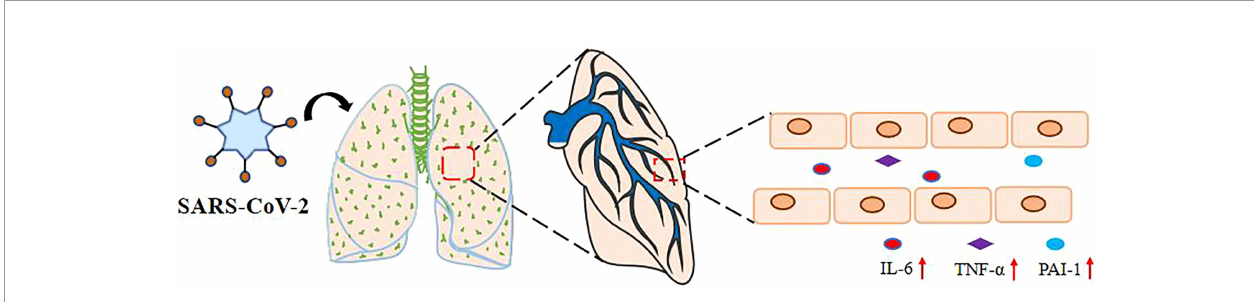
FIGURE 1 | SARS-Co-2 upregulates plasma IL-6, TNF- a , and PAI-1 levels. The levels of IL-6, PAI-1, and TNF- a in the serum of severely and critically ill COVID-19 patients with SARS-CoV-2 pulmonary infection via the respiratory tract were signi fi cantly increased.